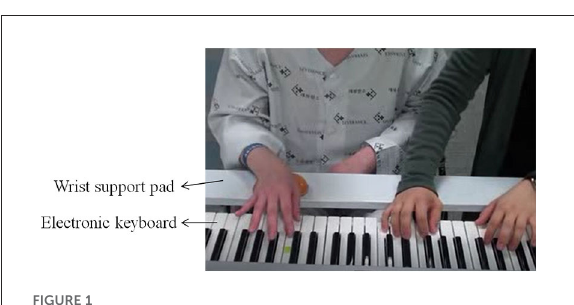
FIGURE1 A participant’s position for movement-specific keyboard playing